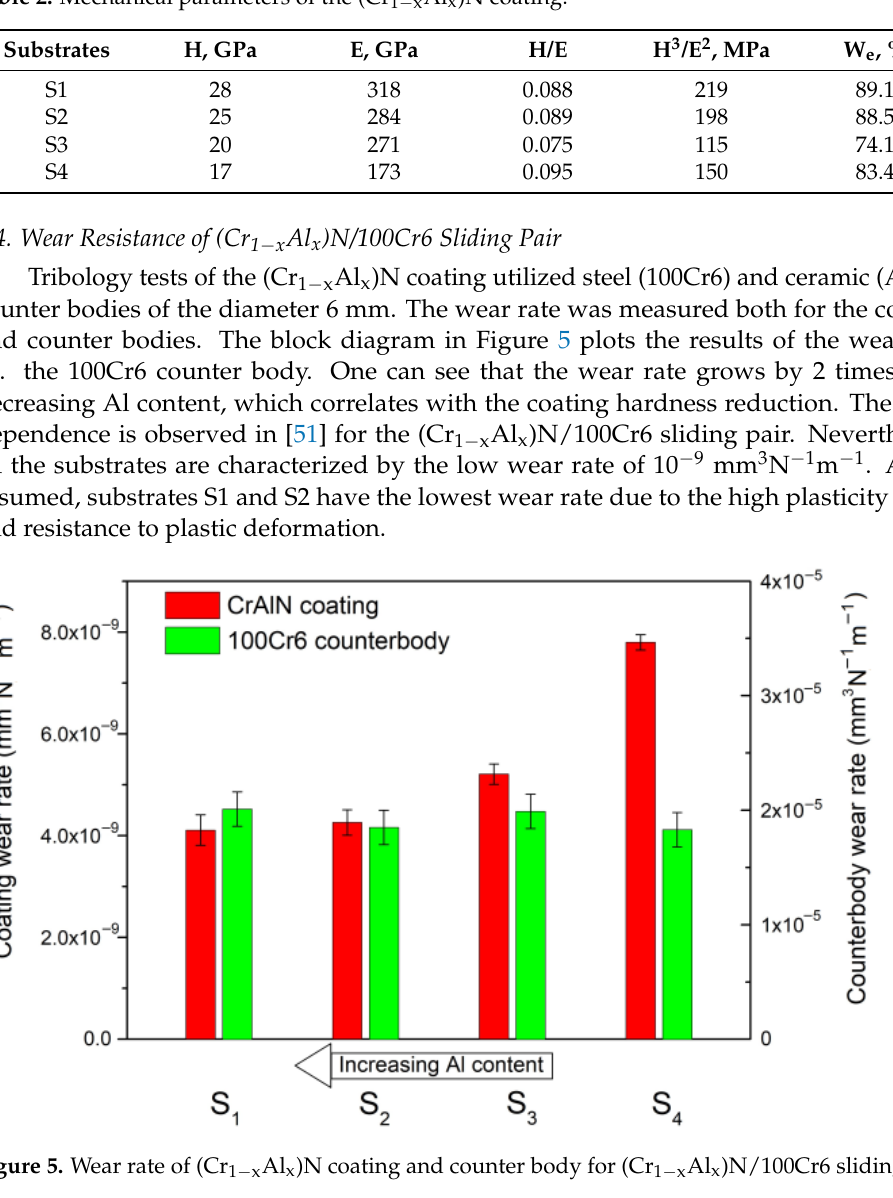
Table 2. Mechanical parameters of the (Cr 1−x Al x )N coating. Substrates H, GPa E, GPa H/E H 3 /E 2 , MPa W e , % S1 28